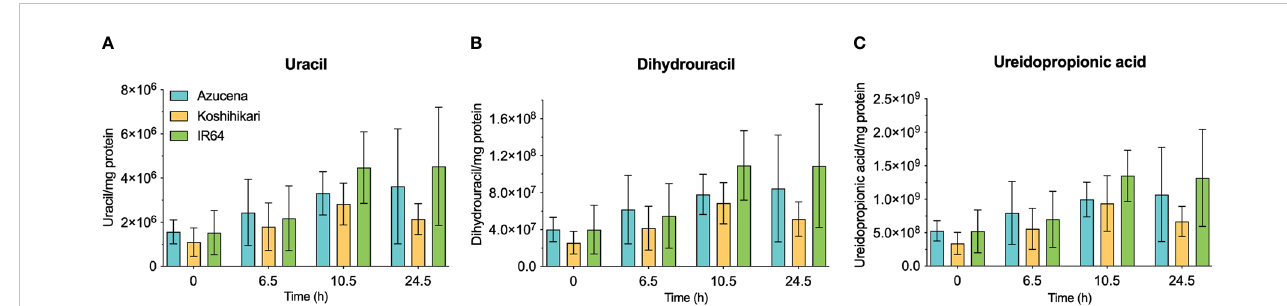
FIGURE 5 Levels of selected metabolites of pyrimidine catabolism in rice leaves during 24 hours of exposure to salt stress in salt-sensitive and salt-tolerant cultivars. Three rice cultivars were grown hydroponically in a phytotron, and 200 mM NaCl was added to growth media on day 17. Koshihikari and Azucena are salt-sensitive, and IR64 is salt-tolerant. Leaves were harvested during a 24-hour period post-treatment, and the levels of selected metabolites of pyrimidine catabolism, uracil (A) , dihydrouracil (B) , and ureidopropionic acid (C) , were measured. Values on the y-axis represent the integrated area of peaks associated with the metabolite of interest, normalized to mg protein in the sample. It is important to note that the levels of different compounds cannot be compared. No signi fi cant differences in metabolite levels were observed in a two-way ANOVA using GraphPad Prism 9.